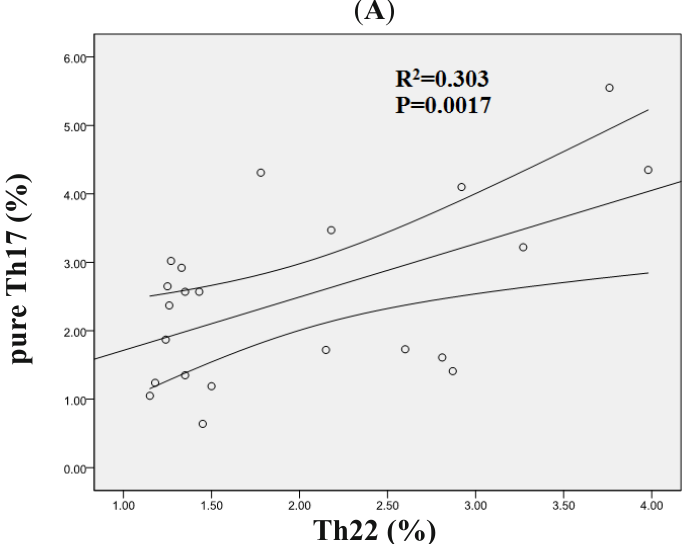
( B ) A negative correlation between Th22 cells and Th1 cells in ND AML patients; ( C )